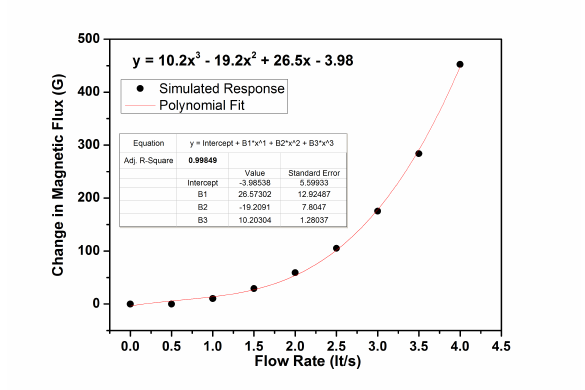
Fig. 2. Simulation response of TFMS in change in magnetic flux with respect to water flow